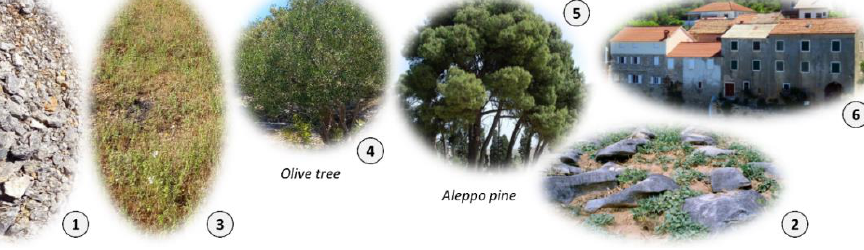
Figure 11. Example of segmented images and defined LU/LC classes.